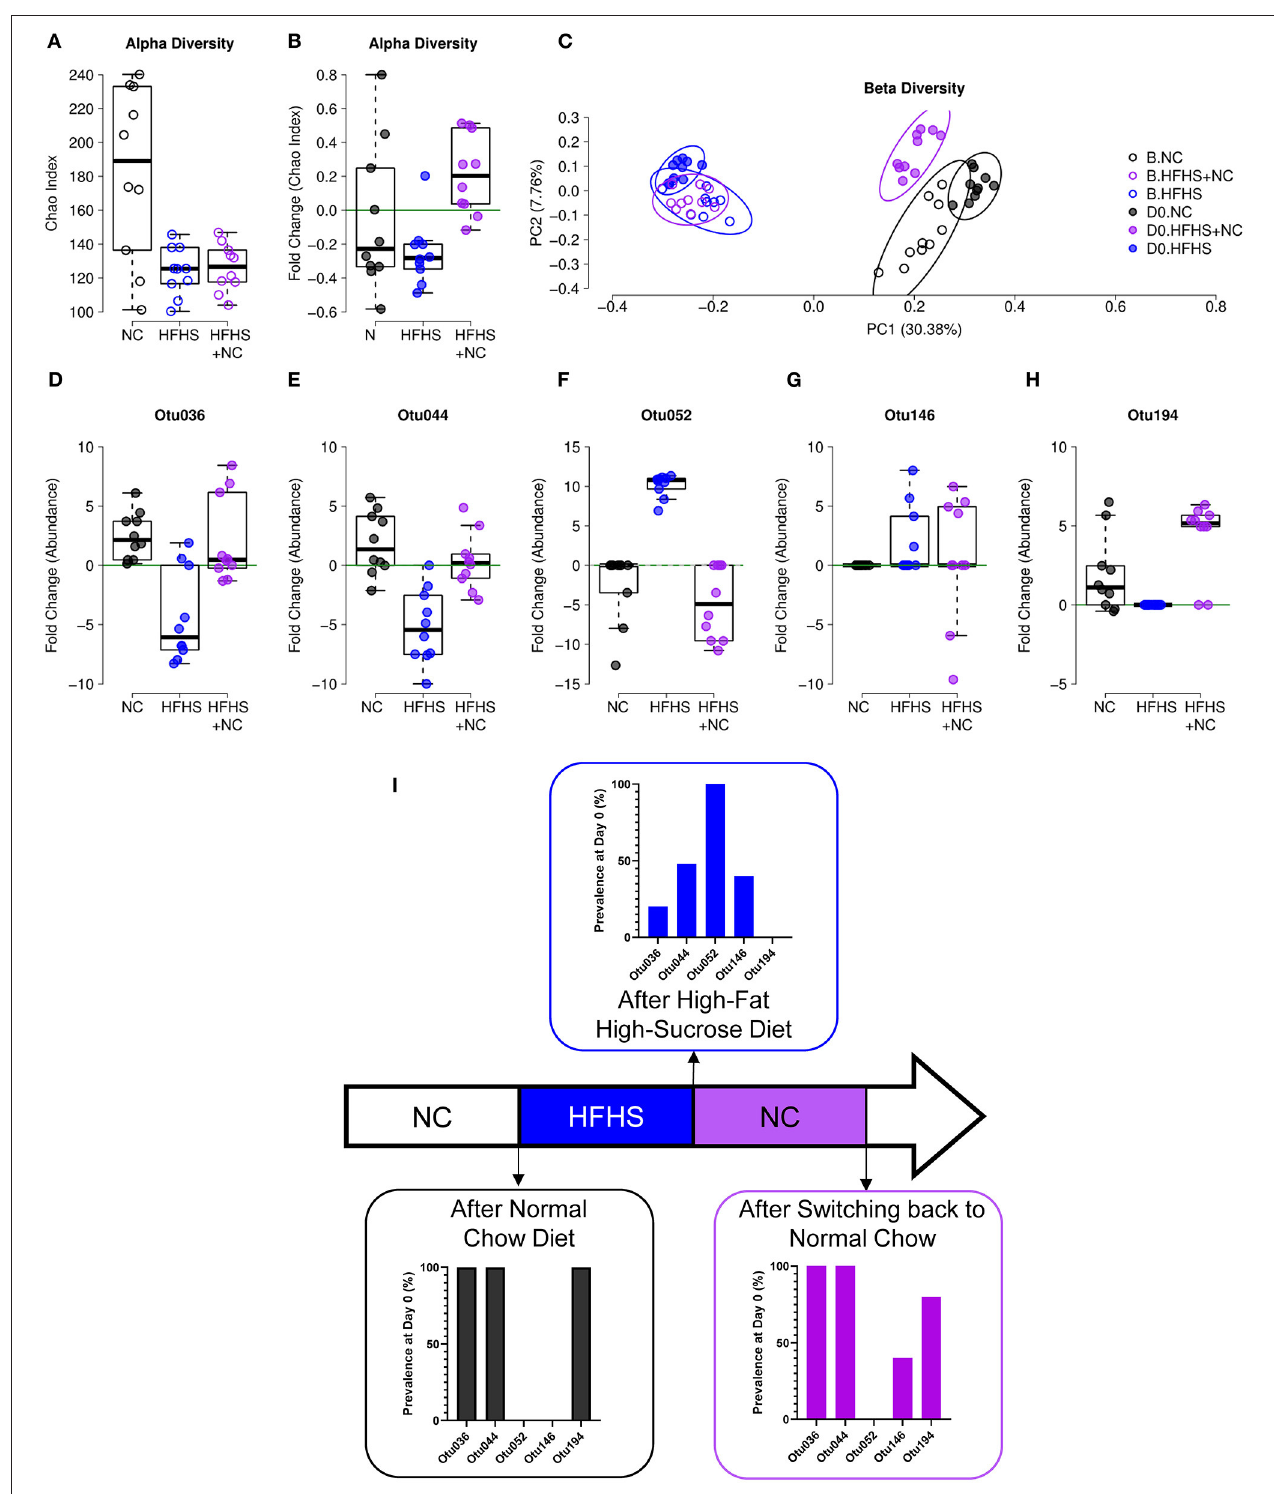
FIGURE 6 | Incomplete recovery of microbiota dysbiosis. (A) α -diversity measured by Chao index of NC-fed, HFHS-fed, or HFHS + NC-fed ( N = 10 per group) mice at baseline B. (B) Evolution of species richness measured by a fold change of Chao index at day zero (D0) relative to B. (C) Principal coordinate analysis (PCoA) of Jaccard β -diversity index showing NC-fed, HFHS-fed, or HFHS + NC-fed mice, at B and D0. (D–H) Fold change of abundances at D0 relative to B of the five operational taxonomic units (OTUs) identified as an indicator for diet in the 8-weeks experiment (see Supplementary Figure 6 and EV8). (I) Prevalence of indicated OTUs at D0 after 16 weeks of NC, HFHS, or NC following HFHS.